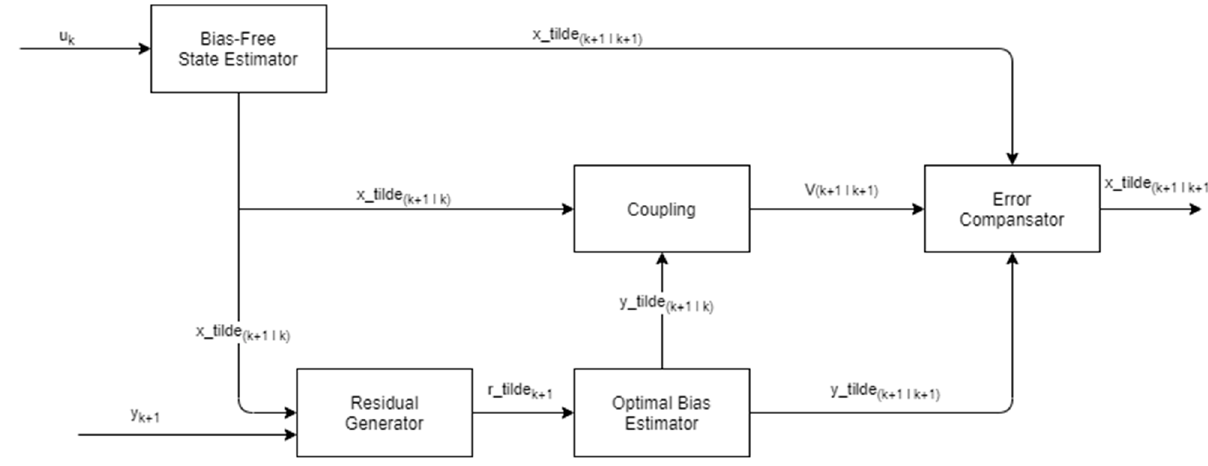
Figure 3. TSKF Block Diagram.